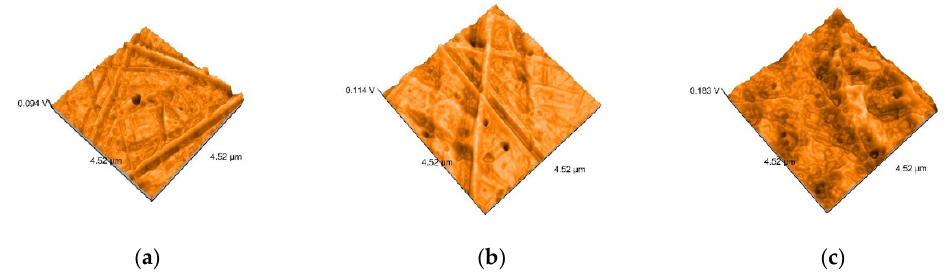
Figure 13. 3D AFM images of the thermoformed D samples immersed in K: ( a ) DKP (Sa = 7 nm, Sp = 26 nm, Sv = − 32 nm); ( b ) DKT (Sa = 6.7 nm, Sp = 58 nm, Sv = − 27 nm); ( c ) DKX (Sa = 8.6 nm, Sp = 43 nm, Sv = − 50 nm).